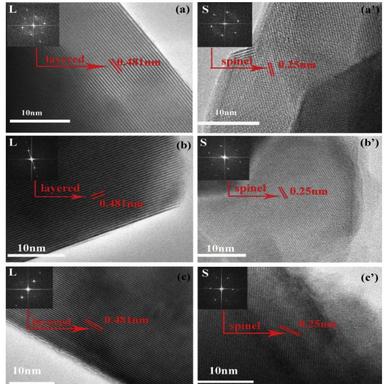
The TEM and the inset FFT images of the layered domain and the spinel domain in s900 (a, a'), s1000 (b, b') and s1100 (c, c') samples. L: layered structure; S: spinel structure.